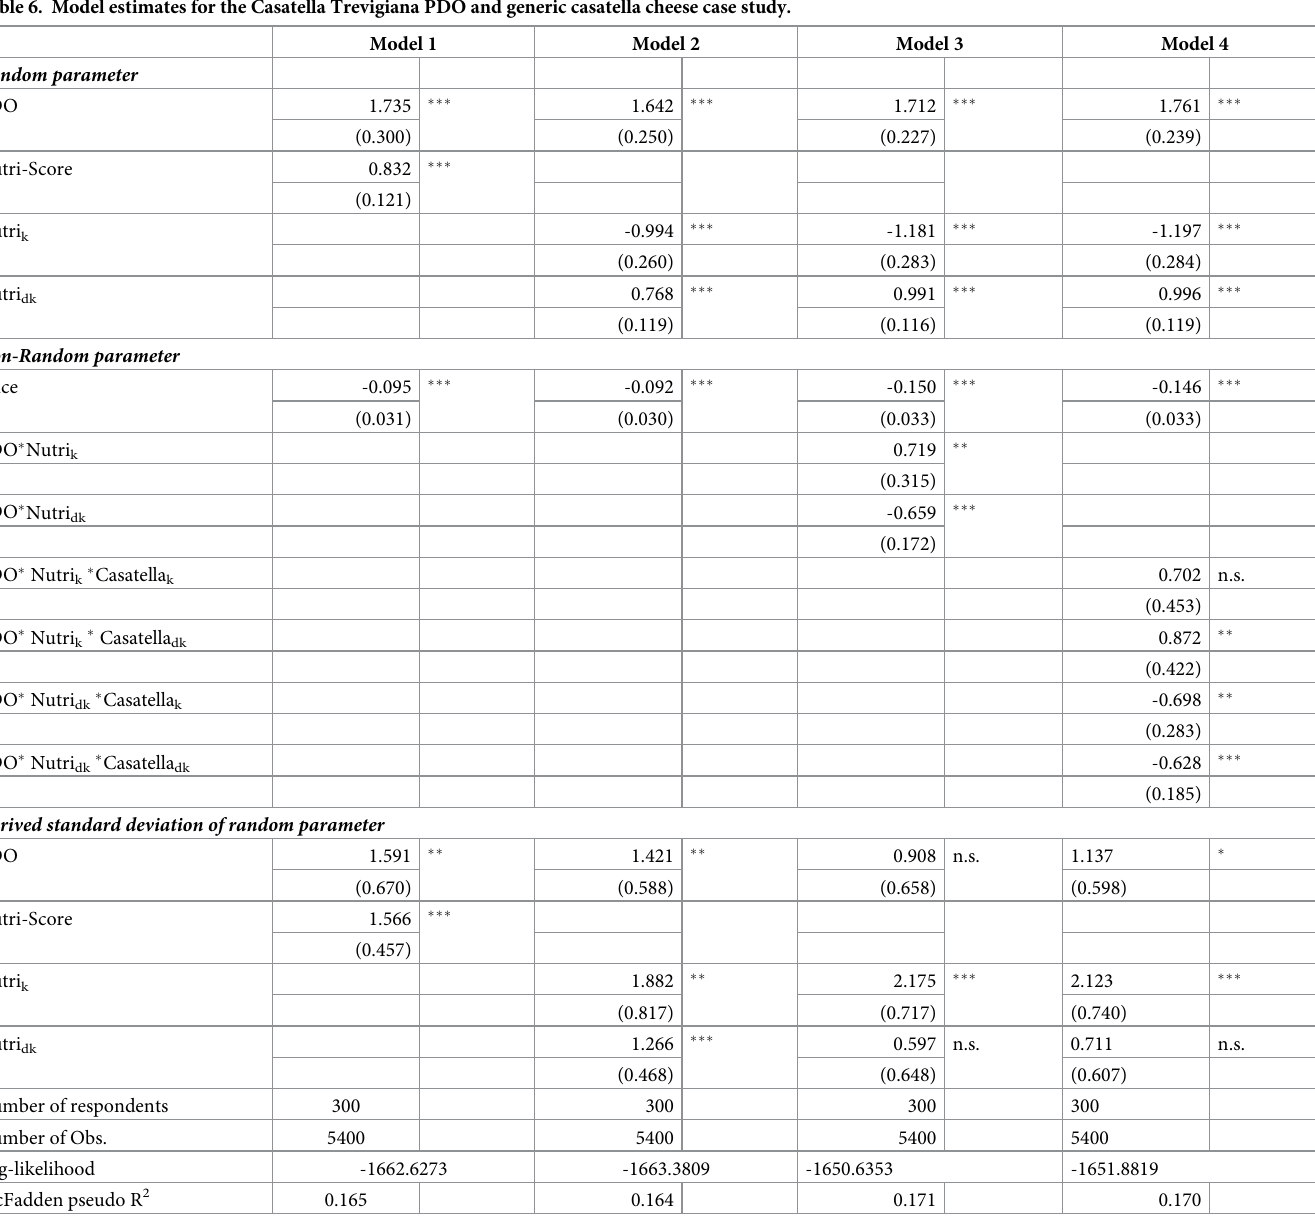
Table 6. Model estimates for the Casatella Trevigiana PDO and generic casatella cheese case